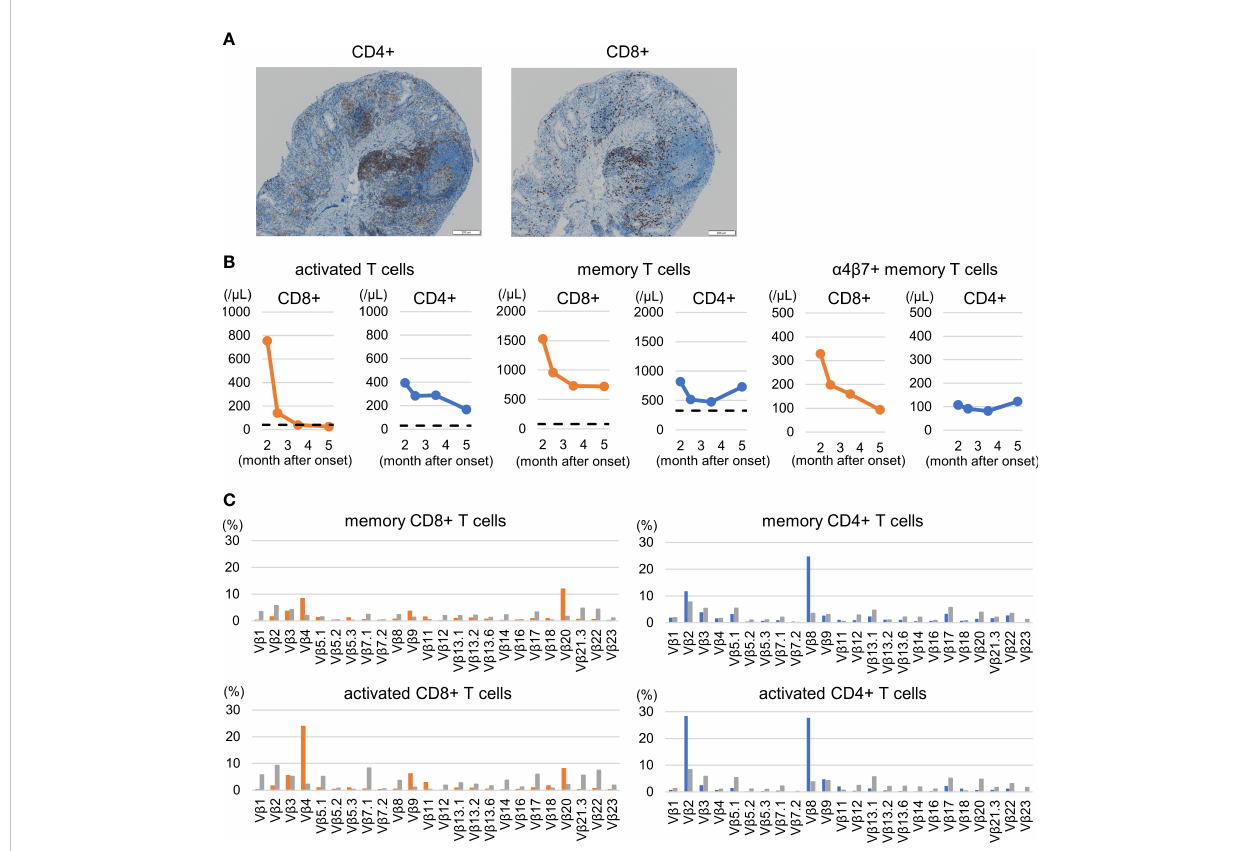
FIGURE 3 Colorectal histological and peripheral immunophenotyping. (A) Rectal histology: Moderate to severe lymphocyte in fi ltration and equally composed of CD8 + and CD4 + lymphocytes are shown. (B) Changes in T cell subsets: activated T cells (HLA-DR + CD38 + ), memory T cells (CD45RO + ), and a 4 b 7 + memory T cells. Increases in activated and memory T cells, including a 4 b 7-expressing cells, particularly CD8+ T cells, are shown. The dashed lines indicate the median value of healthy children around the same age as the patient according to reference values (19). (C) Changes in T cell receptor repertoire during the active pre-treatment period. The expansion of V b 4 and V b 20 in memory CD8 + T cells and of V b 2 and V b 8 in memory CD4 + T cells were observed. A similar trend was observed in activated T cells. The gray bar indicates the control value of a healthy 11-year- old boy. See supplementary materials of panel design and gating strategy for peripheral T-cell subsets and T-cell receptor